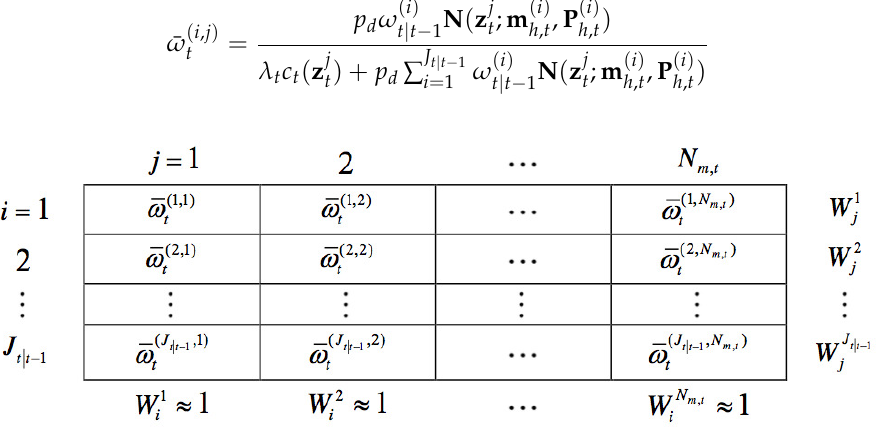
Figure 4. Weight matrix: a symbolic representation of updated